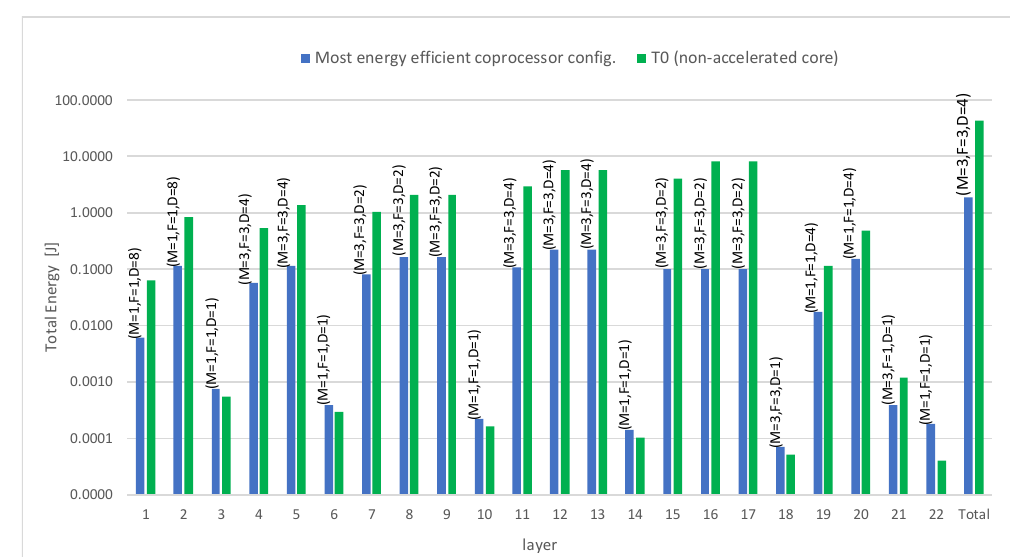
18 of 22 Figure 17. Hardware overhead normalized to the non-accelerated T0 core. Figure 18 shows the total energy consumed by the most efficient of all the explored